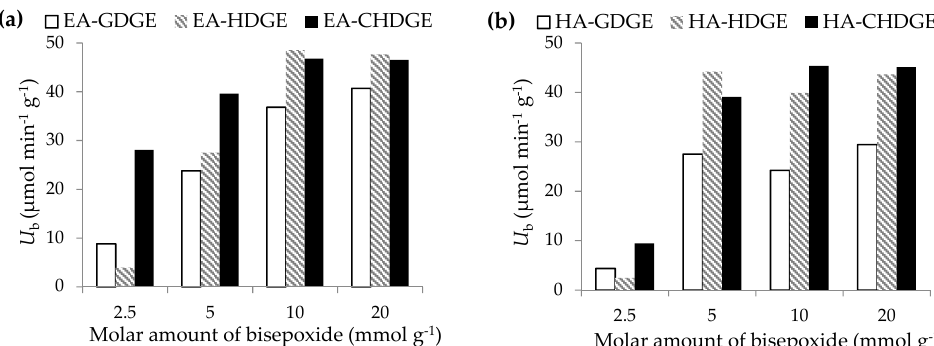
Figure 3. Optimization of the bisepoxide activation of ethylamine (EA) and hexylamine (HA) resins for Ca LB immobilization. Effect of molar amount of bisepoxide to mass resin ratio (mmol g − 1 ) of CHDGE, HDGE and GDGE on Ca LB activity. Experiments were performed as described in Section 3.7.